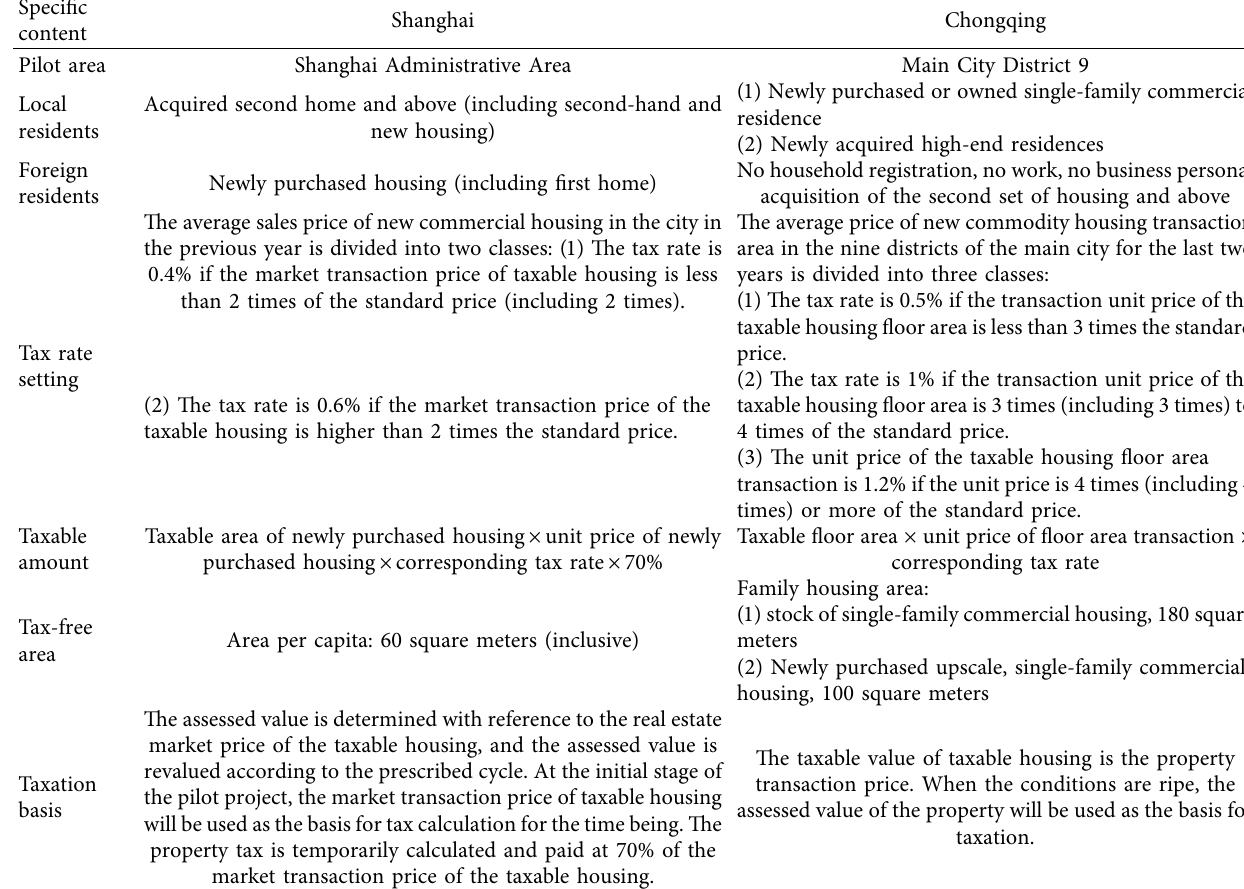
Table 1: Shanghai and Chongqing pilot reform policy